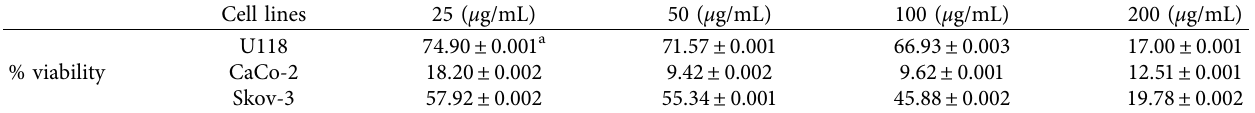
Table 2: Cytotoxic effects of AgNPs on cell lines ( n � 3, mean ± standard